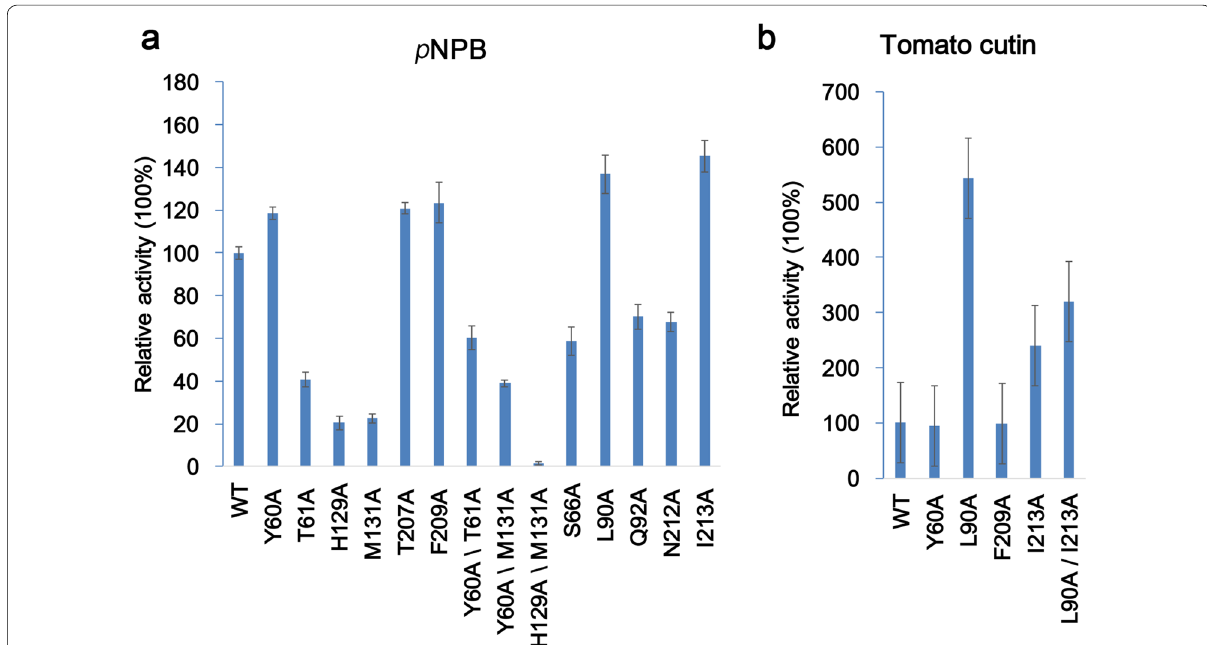
Fig. 3 Hydrolysis activities of the cutinase variants. a Catalytic activities of WT and variant cutinases towards the substrate p NPB. b Hydrolysis activities of the cutinase mu means with standard deviations ( n =